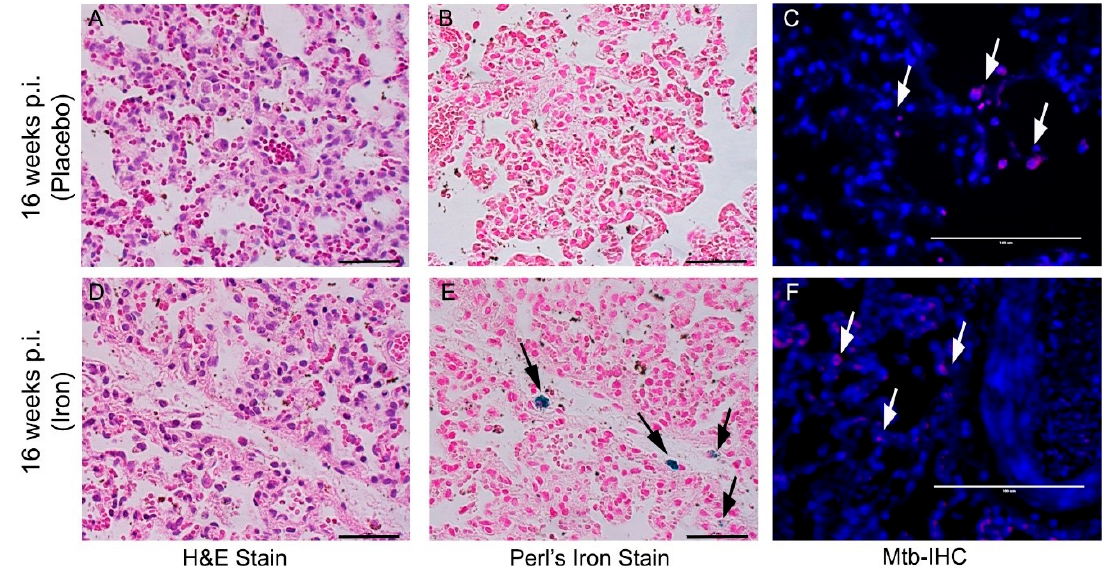
Figure 9. E ff ect of Fe-supplementation on rabbit lung pathology at 16-weeks post Mtb infection. Histopathology of rabbit lungs infected with Mtb CDC1551 at 16 weeks post infection with ( A – C ) or without ( D – F ) Fe-supplementation showing disease pathology (H&E stain; A , D ), iron deposition (Perls’ iron stain; B , E ) and Mtb (by immunohistochemistry; C , F ). Dark arrows in ( E ) show cellular iron deposition (blue color). White arrows in ( C , F ) show Mtb (purple color). The scale bar for all the images is 50 µ m. Sections were photographed at 400 × ( A , B , D , E ) or 600 × ( C , F ) of original magnification.